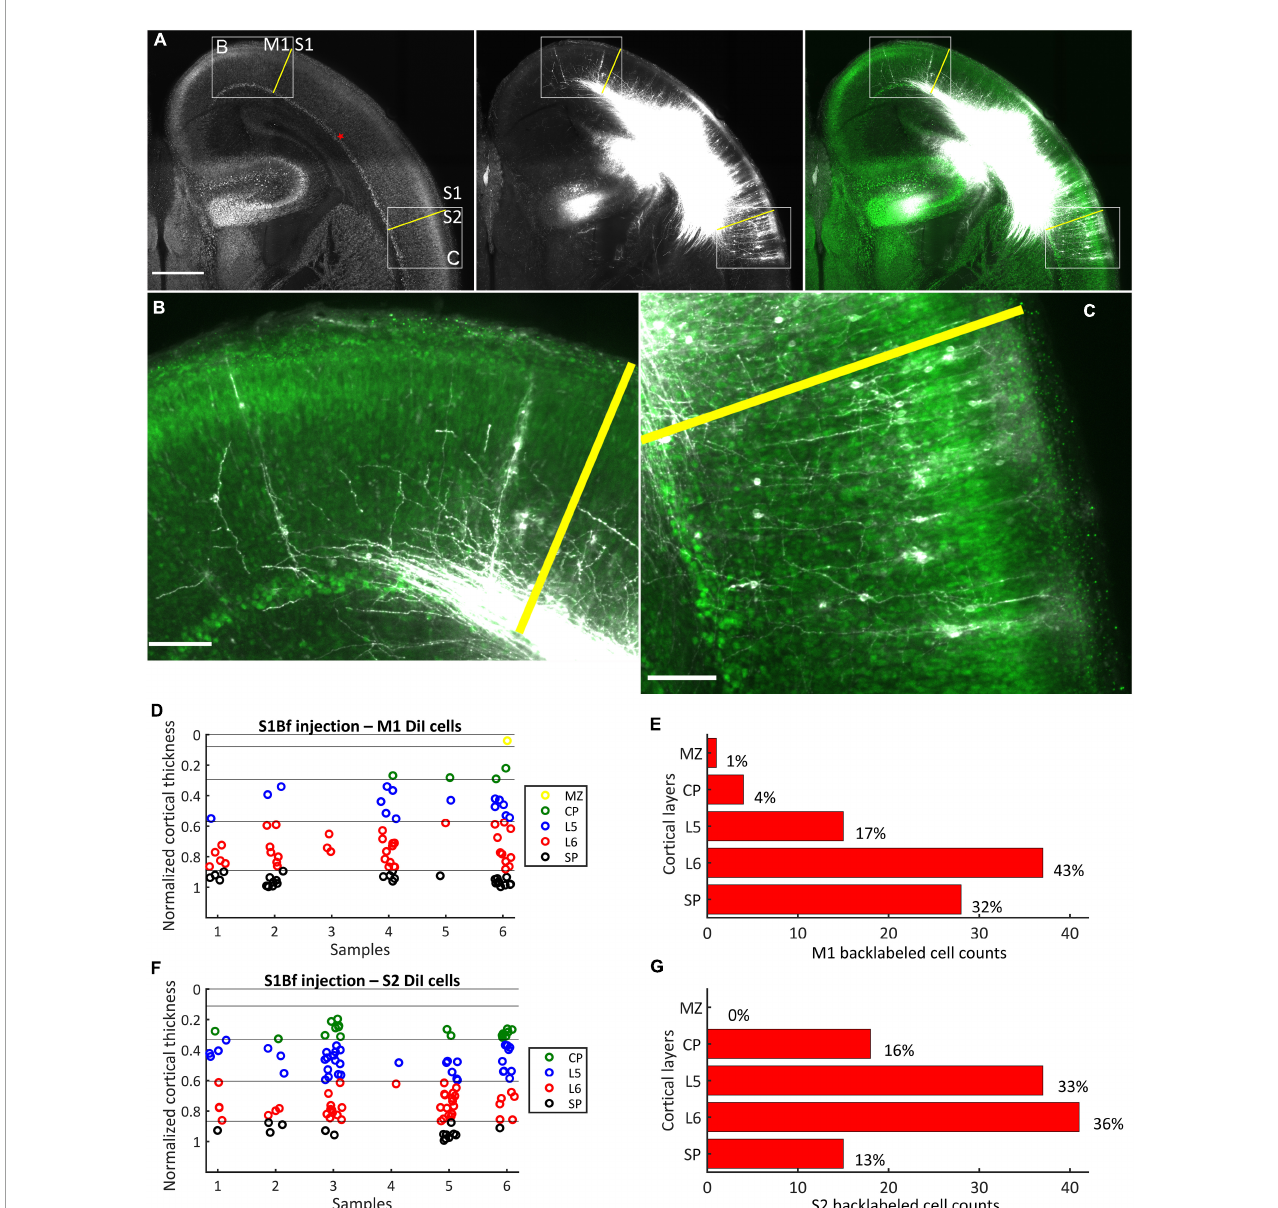
FIGURE1 DiI labeling pattern and localization of DiI backlabeled cells in M1 and S2 on six S1Bf injected samples. (A) Representative photomicrographs showing the DiI labeling pattern in M1 and S2 cortices of S1Bf injected sample. Image was prepared as a maximum intensity projection of selected stacks of 350 µ m thick samples. Left panel: NeuN counterstain of DiI injected sample. Red asterisk indicates the DiI injection site in S1Bf. Yellow lines show border between M1 and S1 (upper left) and between S1 and S2 (lower right) as estimated from reference points in the developing mouse brain atlas (Paxinos, 2007). Middle panel: DiI tracer spreading pattern toward M1 and S2 cortices. Right panel: Composite image of the DiI signal and the pseudocoloured NeuN signal showing the DiI spread toward M1 and S2 cortices. (B) Representative M1 area, as indicated in panel (A) (rectangle a), showing backlabeled cell distribution across cortical layers. (C) Representative S2 area as indicated in panel (A) (rectangle b), showing backlabeled cell distribution across cortical layers. Scale bars are 500 µ m (A) and 100 µ m (B,C) . (D,F) Scatter plots showing the localization of manually detected somata of backlabeled cells through the normalized cortical thickness in M1 (D) and in S2 (F) in 6 S1Bf injected samples. Zero level at the y axis refers to the pial surface, level 1 indicates the SP-white matter boundary. (E,G) Quantification of observed counts of backlabeled cells in M1 (E) and in S2 (G)